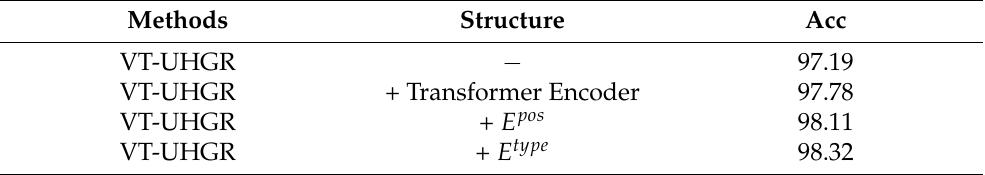
Table 5. Ablation study of the proposed components in VT-UHGR on the CADDY dataset.